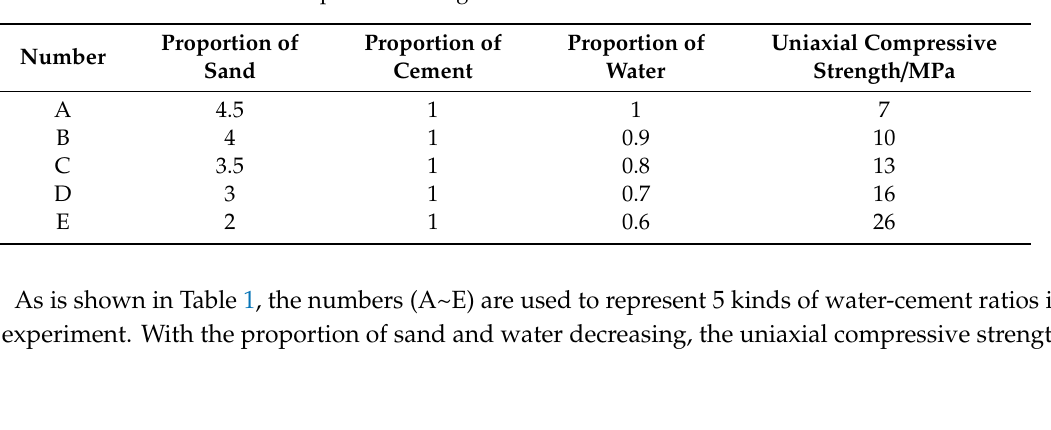
Table 1. Uniaxial compressive strength and cement mortar ratio of matrix